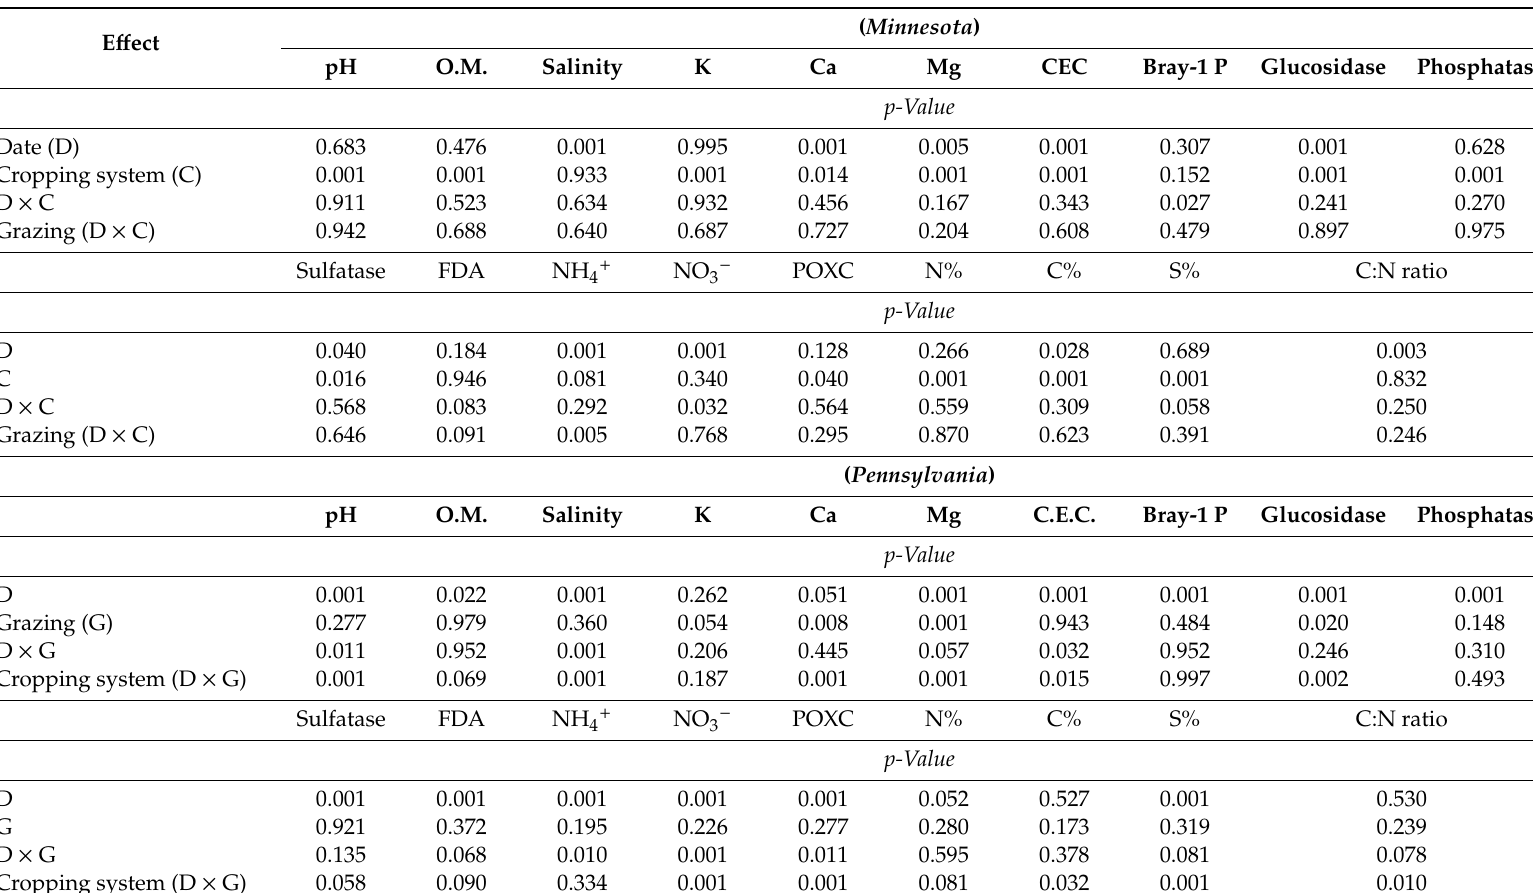
Table 3. Summary of statistical analysis for pH, OM, salinity, K, Ca, Mg, cation exchange capacity (CEC), Bray-1 P, glucosidase, phosphatase, sulfatase, fluorescein diacetate hydrolysis (FDA), NH 4 + , NO 3 − , permanganate oxidizable carbon (POXC), N%, C%, S%, and C:N ratio as a function of sampling date, cropping system and grazing in Minnesota and Pennsylvania from 2015 to